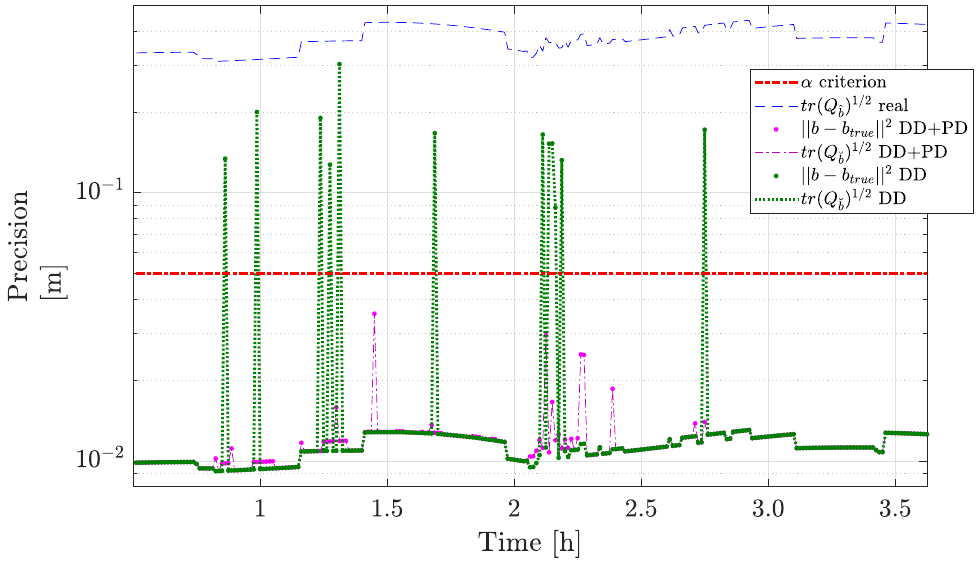
Figure 10. FAR vs Precision-aided PAR scheme RMSE error positioning